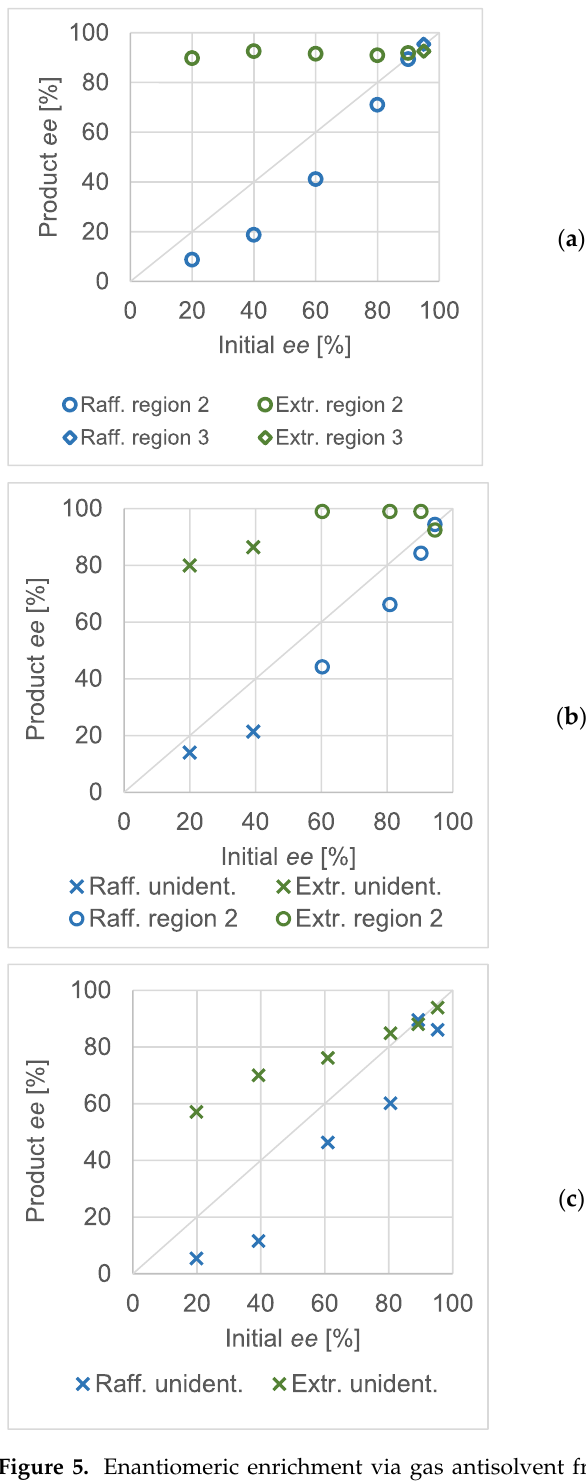
Figure 5. Enantiomeric enrichment via gas antisolvent fractionation at 20 MPa and 35 °C. The con- centration of methanol was constant; approximately 90 mg/mL. ( a ) The overall concentration of the salt was 2.3 mg/mL. ( b ) The overall concentration of the salt was 1.15 mg/mL. ( c ) The overall con- centration of the salt was 0.60 mg/mL.